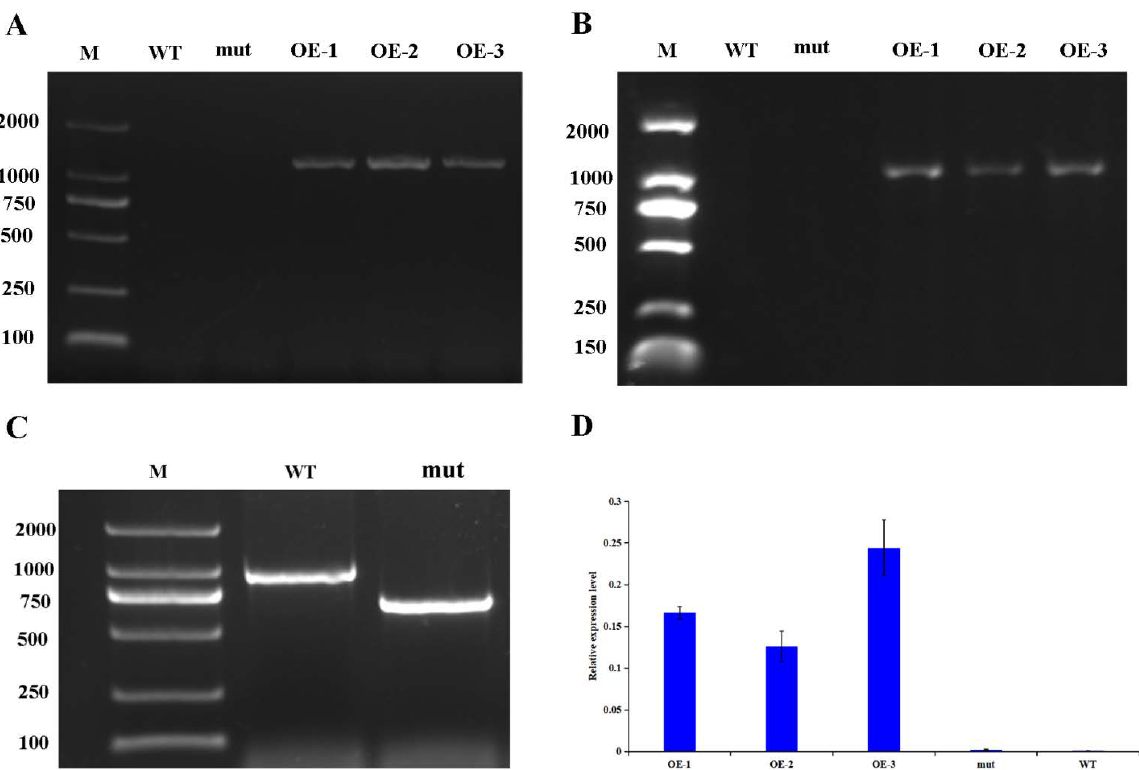
Figure 9. PCR analysis of the transgenic plants of GhWRKY53 . ( A ) The results of DNA identification of GhWRKY53 . in transgenic A. thaliana ; ( B ) The results of cDNA identification of GhWRKY53 in transgenic A. thaliana ; ( C ) Identification of AtWRKY46 mutant in A. thaliana . Primers: LP, RP and BP. ( D ) qPCR identification of GhWRKY53 in transgenic A. thaliana . Note: Lane M: Marker 2000 bp; WT: Amplification of GhWRKY53 gene in wild type A. thaliana ; mut: Amplification